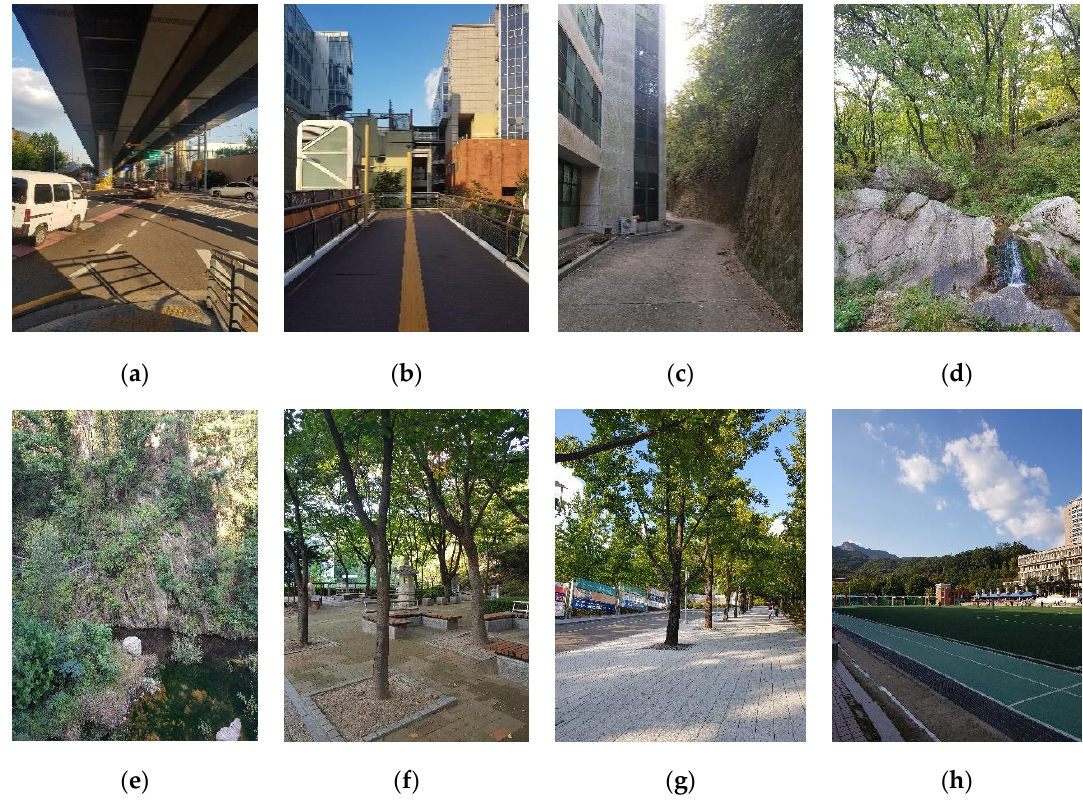
Figure 8. Outdoor environment for data collection: ( a ) under a highway, ( b ) walking road, ( c ) high obstacles, ( d ) thin forest, ( e ) beside a mountain, ( f ) University campus, ( g ) street, ( h ) playground.